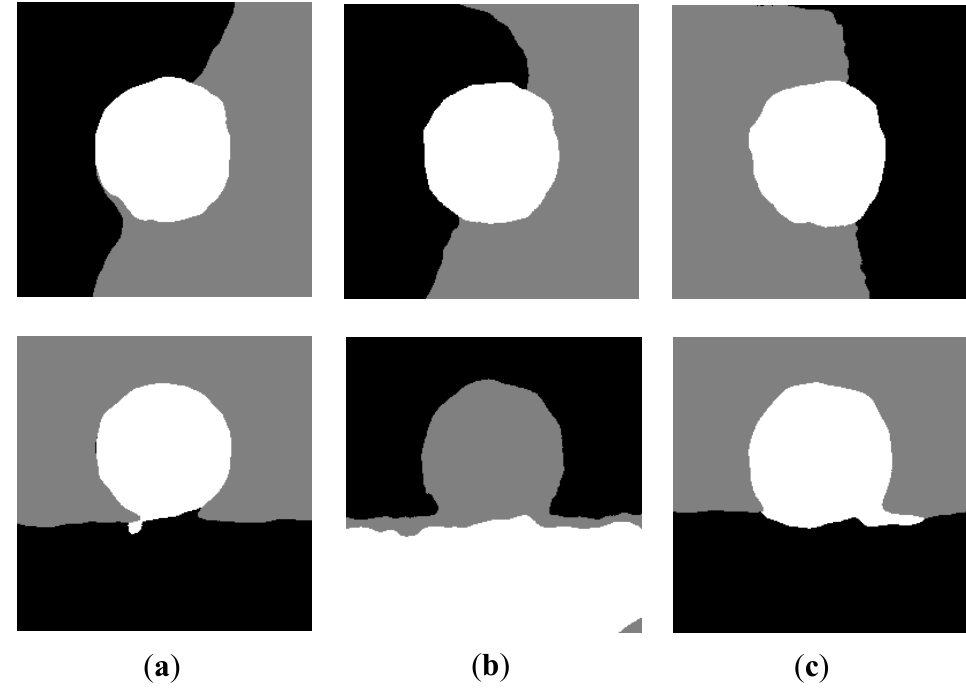
Figure 9. Segmentation results on texture images with speckle noise. ( a ) original images; ( b ) var = 0.05; ( c ) var = 0.10.